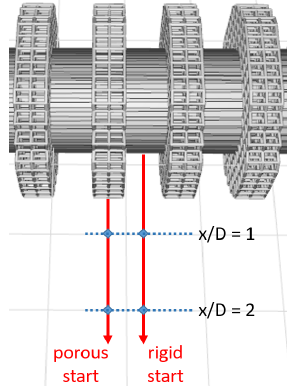
Figure 24. Probe movement behind the cylinder for spaced and helical